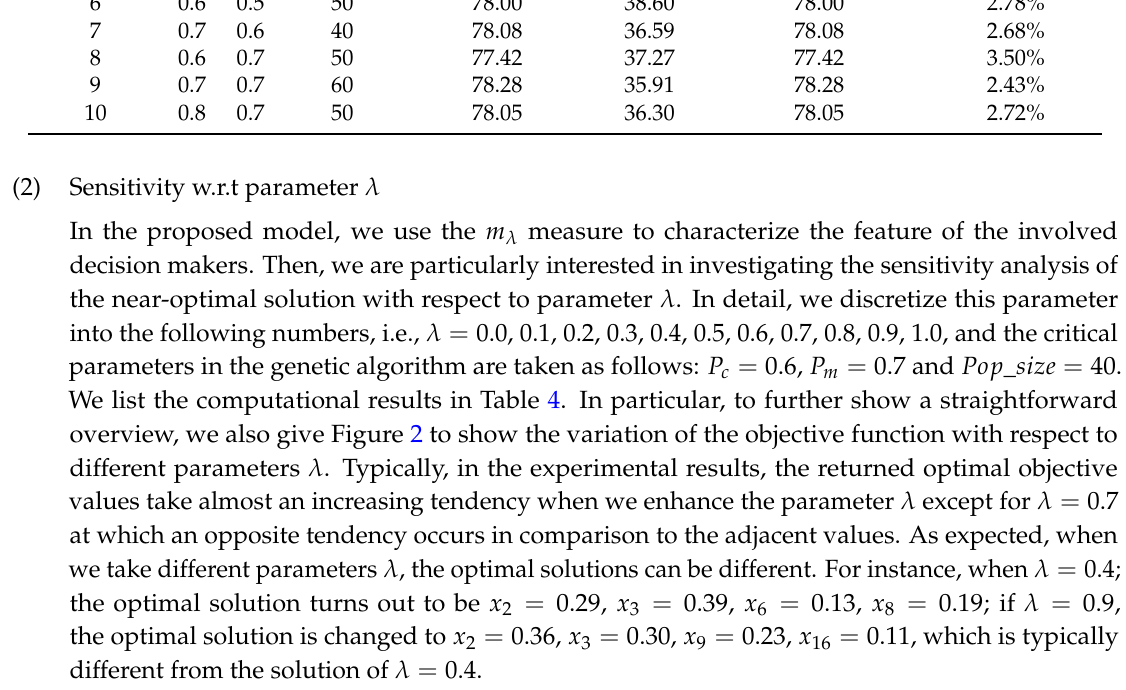
Table 4. The computational results with different λ .